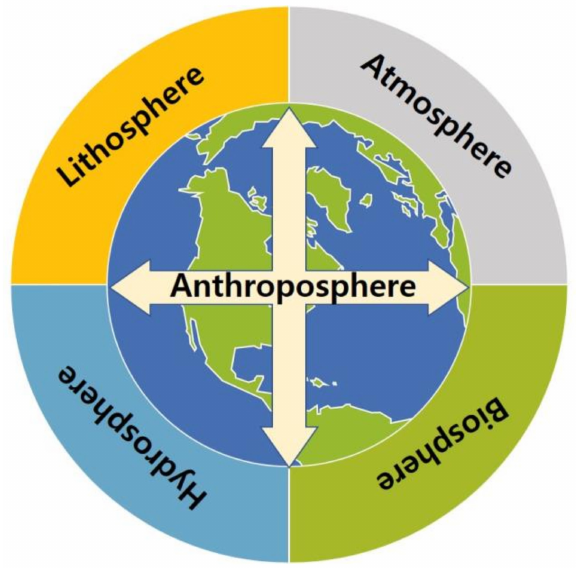
Figure 1. Five spheres of the Earth